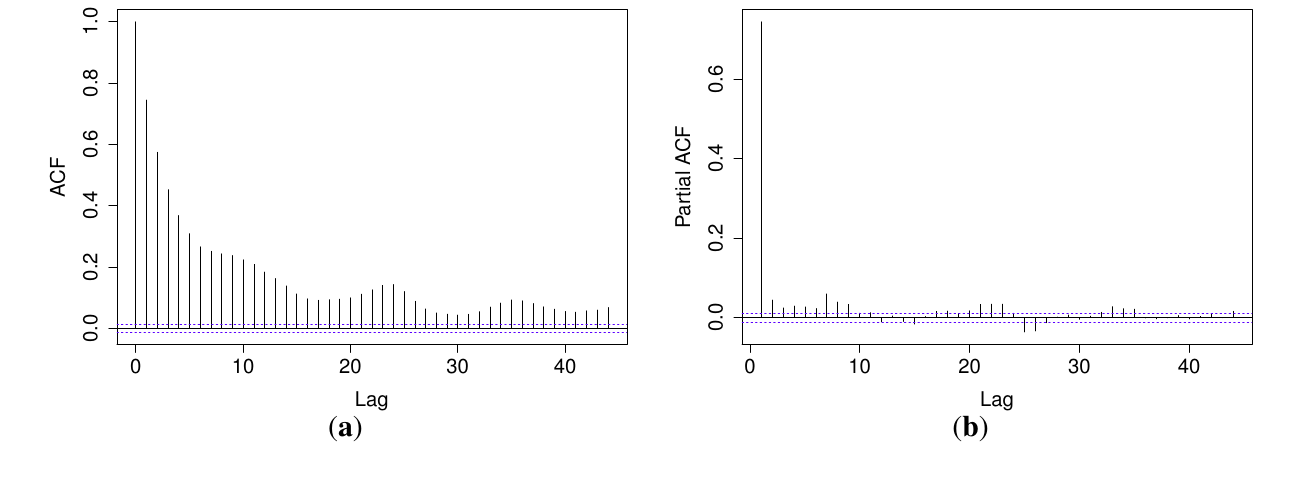
Figure 8. The rank ACF ( a ) and PACF ( b ) for the PIT of the forecasts from the QR-E